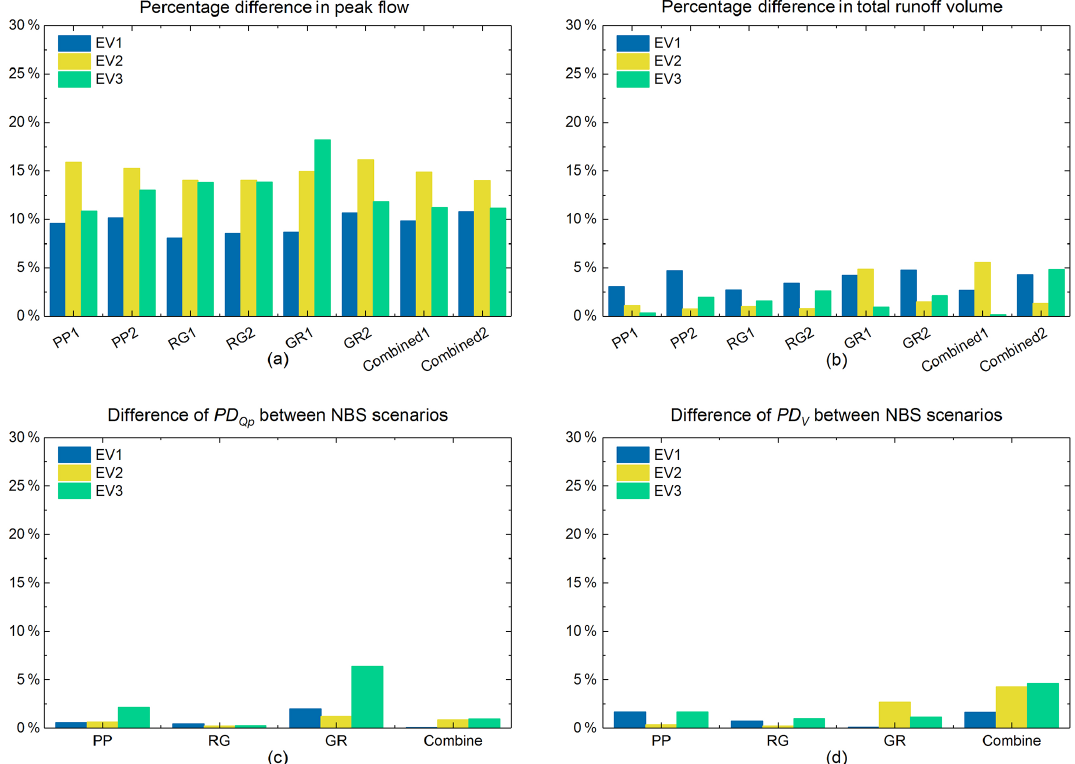
Figure 17. (a) Percentage difference in peak flow of all NBS scenarios under the three distributed rainfall events and the three uniform rainfall events. (b) Percentage difference in total runoff volume of all NBS scenarios under the three distributed rainfall events and the three uniform rainfall events. (c) Difference in PD Qp between the same types of NBS scenarios. (d) Difference in PD V between the same types of NBS